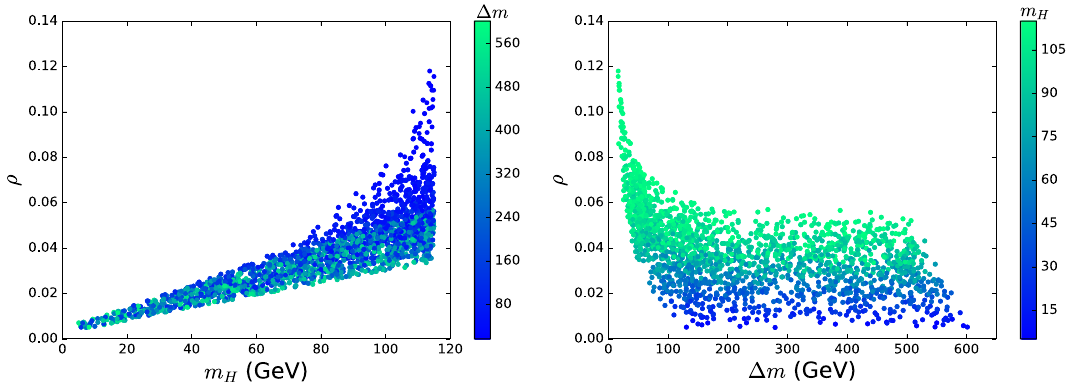
Fig. 2 The surviving samples satisfying the constraints of ”pre-muon g − 2” and muon g − 2 anomaly projected on the planes of ρ versus m H and ρ versus (cid:6) m